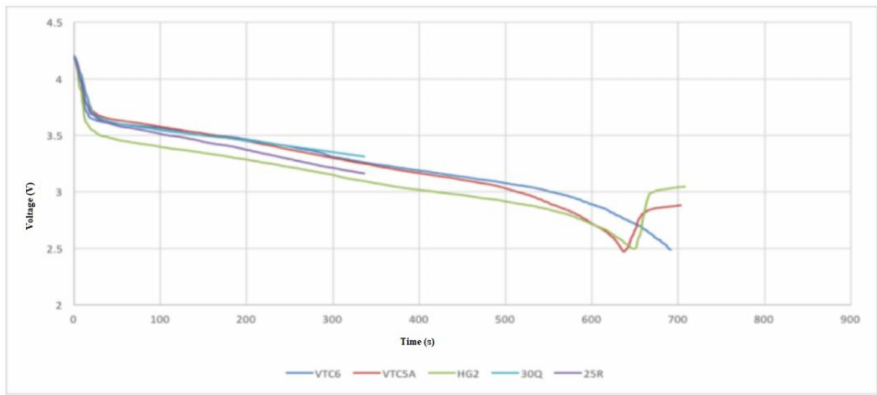
Figure 4. Single cell tests: voltages from 15 A discharge with no